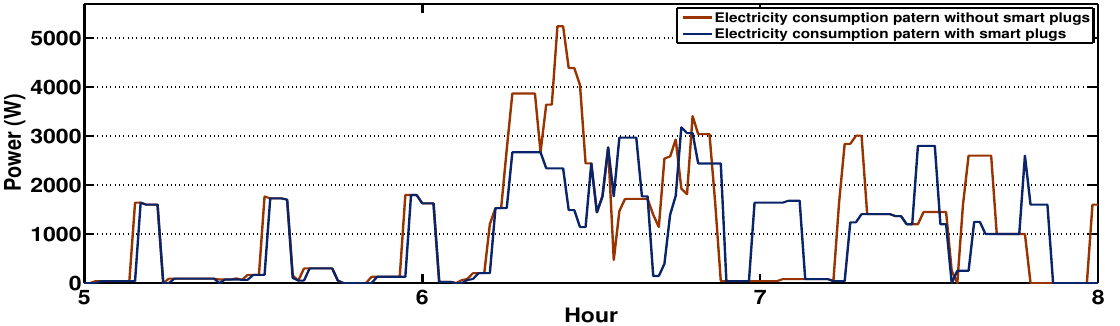
Figure 10. Building power consumption from 05:00 to 08:00 with and without deploying smart plugs in